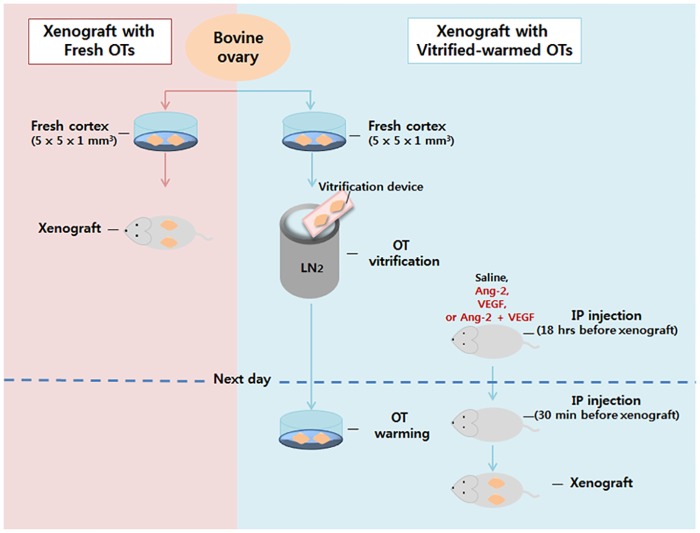
The experimental scheme.Xenografting of fresh and vitrified-warmed ovarian tissues is described on the left and right side of the figure, respectively. OT: ovarian tissue, IP: intraperitoneal injection.